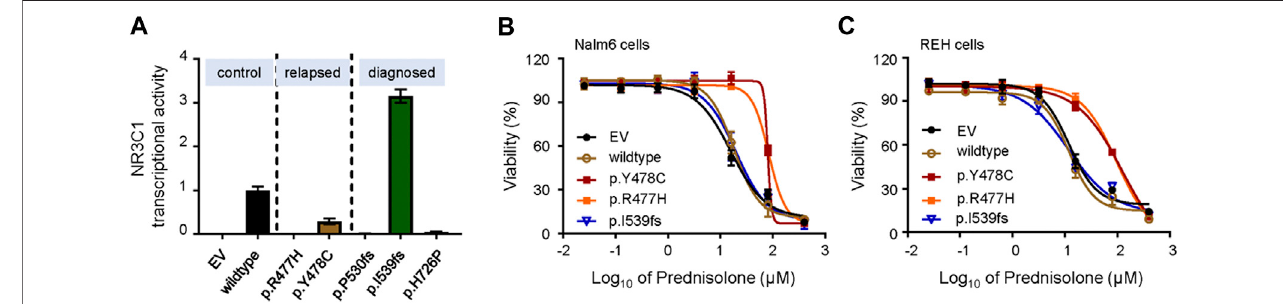
FIGURE2| Transcriptional activity and effect onGCresistance forvarious NR3C1 mutationsinALL cells. (A) Theactivity ofNR3C1 mutants and wild-type NR3C1 treated with dexamethasone was tested by glucocorticoid response element (GRE)-reporter assays (black bar, wild-type; orange bar, p. Y478C; green bar, p. I539fs). (B) CytotoxicityofprednisolonewasexaminedinNalm6cellsharboringmutantNR3C1(blueline,EV;brownline,wild-typeNR3C1;purpleline,p.Y478C;orangeline,p. R477H). (C) Cytotoxicity of prednisone was examined in REH cells with mutant NR3C1 (blue line, EV; brown line, wild-type NR3C1; purple line, p. Y478C; orange line, p. R477H.). NR3C1 mutations (p. Y478C and p. R477H) lead to signi fi cant resistance to prednisolone in ALL lines. Cells were incubated with drugs for 72 h, and viability was then measured by an MTT assay. Experiments were performed in triplicate and repeated at least three times.